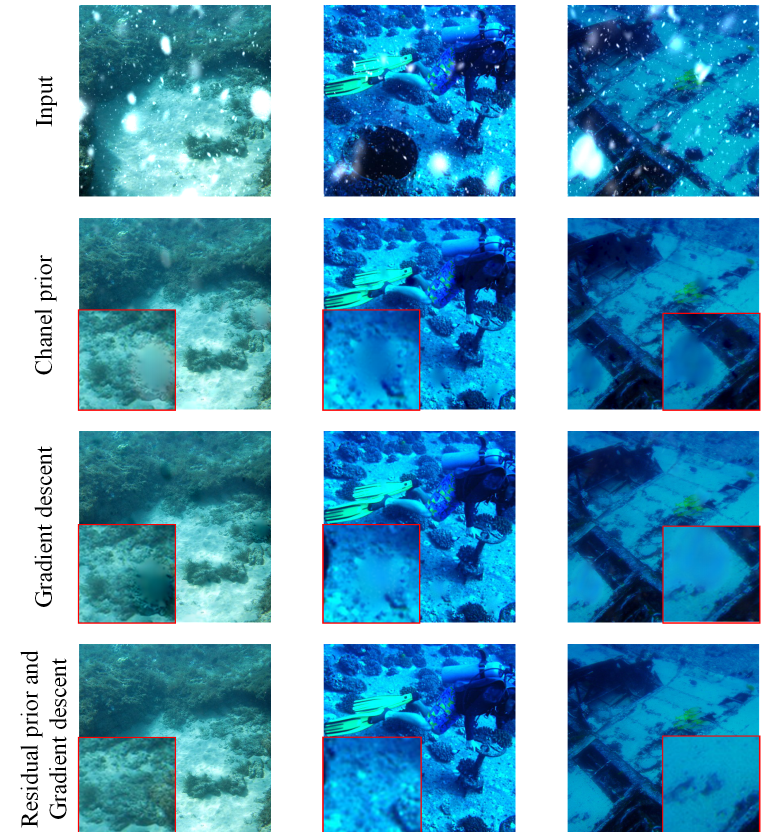
Figure 10. Ablation study of UIR-Net on the MSIRB